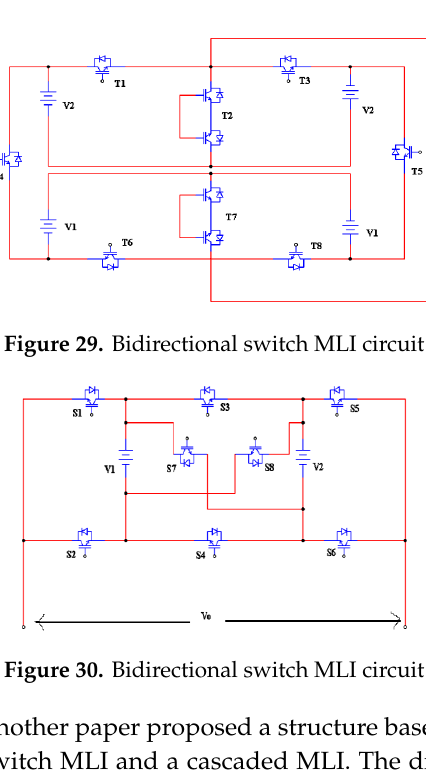
Figure 30. Bidirectional switch MLI circuit.